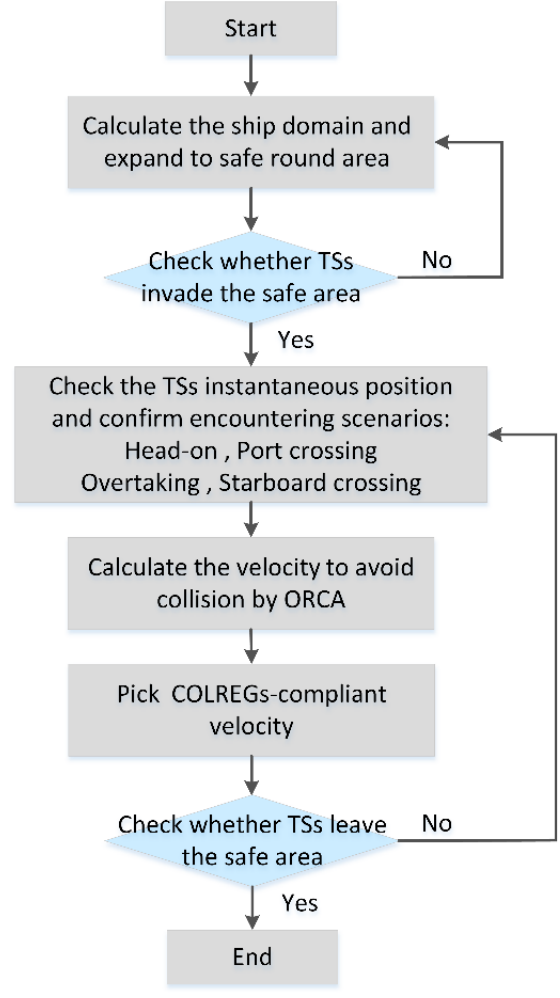
Figure 7. Flow diagram for collision avoidance.